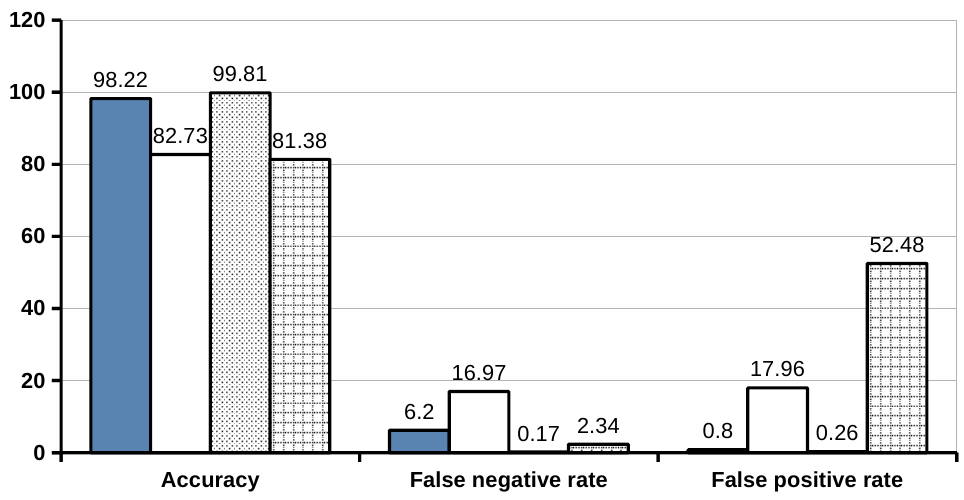
Figure 15. Comparison of classification between ANC and other algorithms in CIC-IDS2017 dataset.